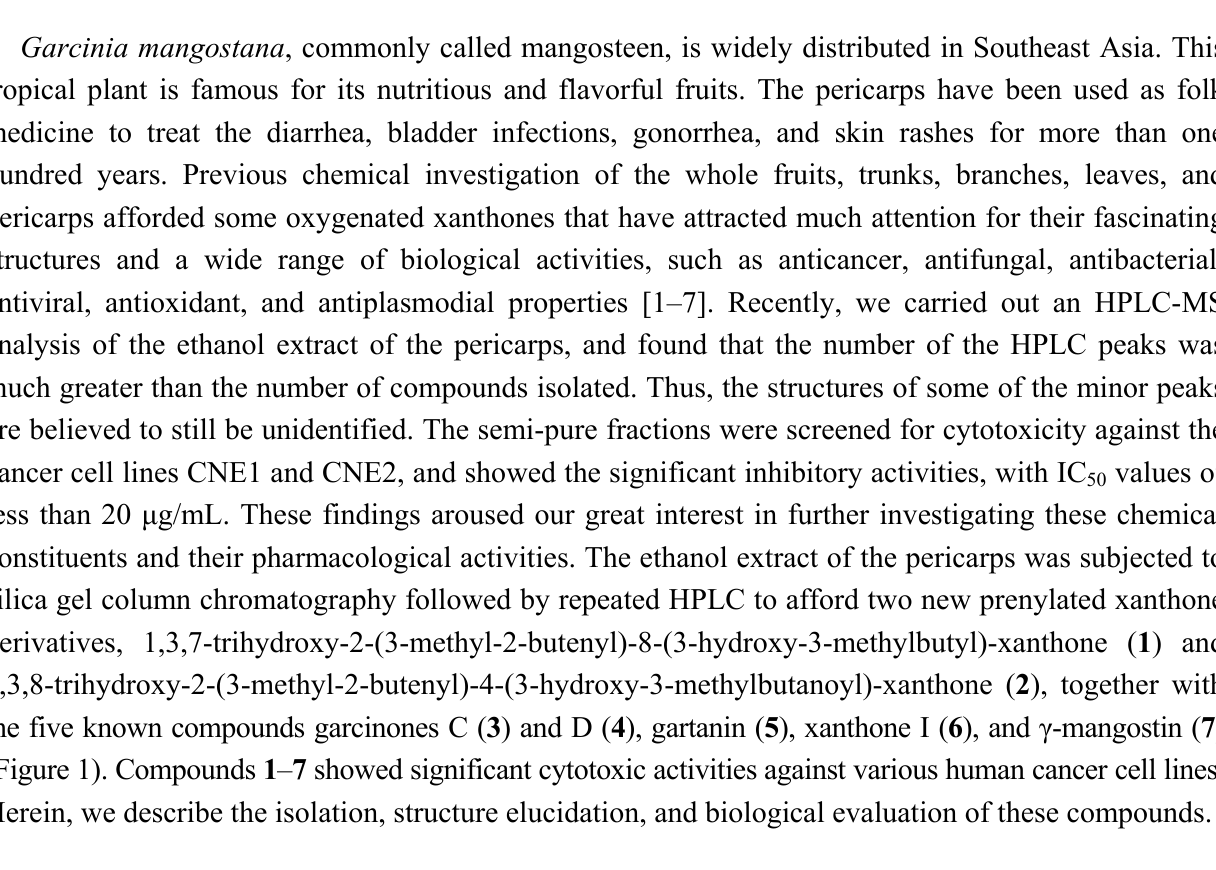
Figure 1. Chemical structures of compounds 1 – 7